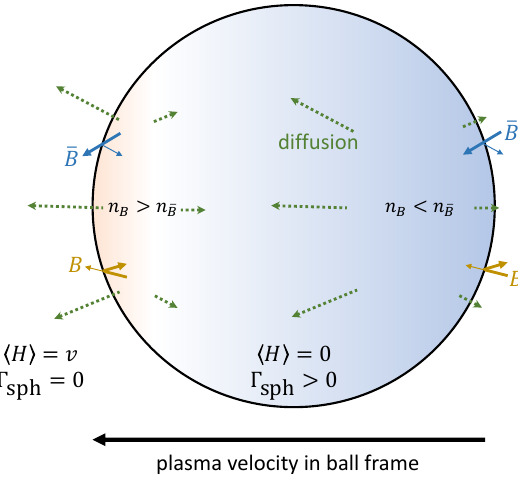
Figure 1 . Schematic depiction of catalyzed baryogenesis facilitated by an electroweak symmetric ball. As the ball moves through the plasma, a baryon asymmetry builds up near its walls due to a CP-violating interaction at the bubble wall. This relies on the relative plasma-ball velocity so that more antibaryons (blue) and baryons (orange) approach the walls from the right side than from the left. The asymmetry then diffuses away from the regions near the wall, but because of the relative velocity between the ball and the plasma, particles near the leading edge tend to diffuse inwards while particles near the trailing edge tend to diffuse outwards (indicated by the green dotted lines). This creates a net baryon number asymmetry inside the ball. Sphalerons, which are only active inside the ball, then convert some of the baryons into leptons, preserving the asymmetry even as the ball passes